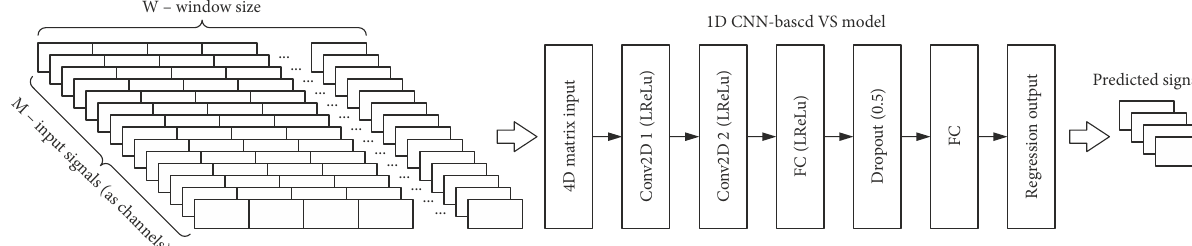
Figure 3. Structure of DNN-based VS with inputs and